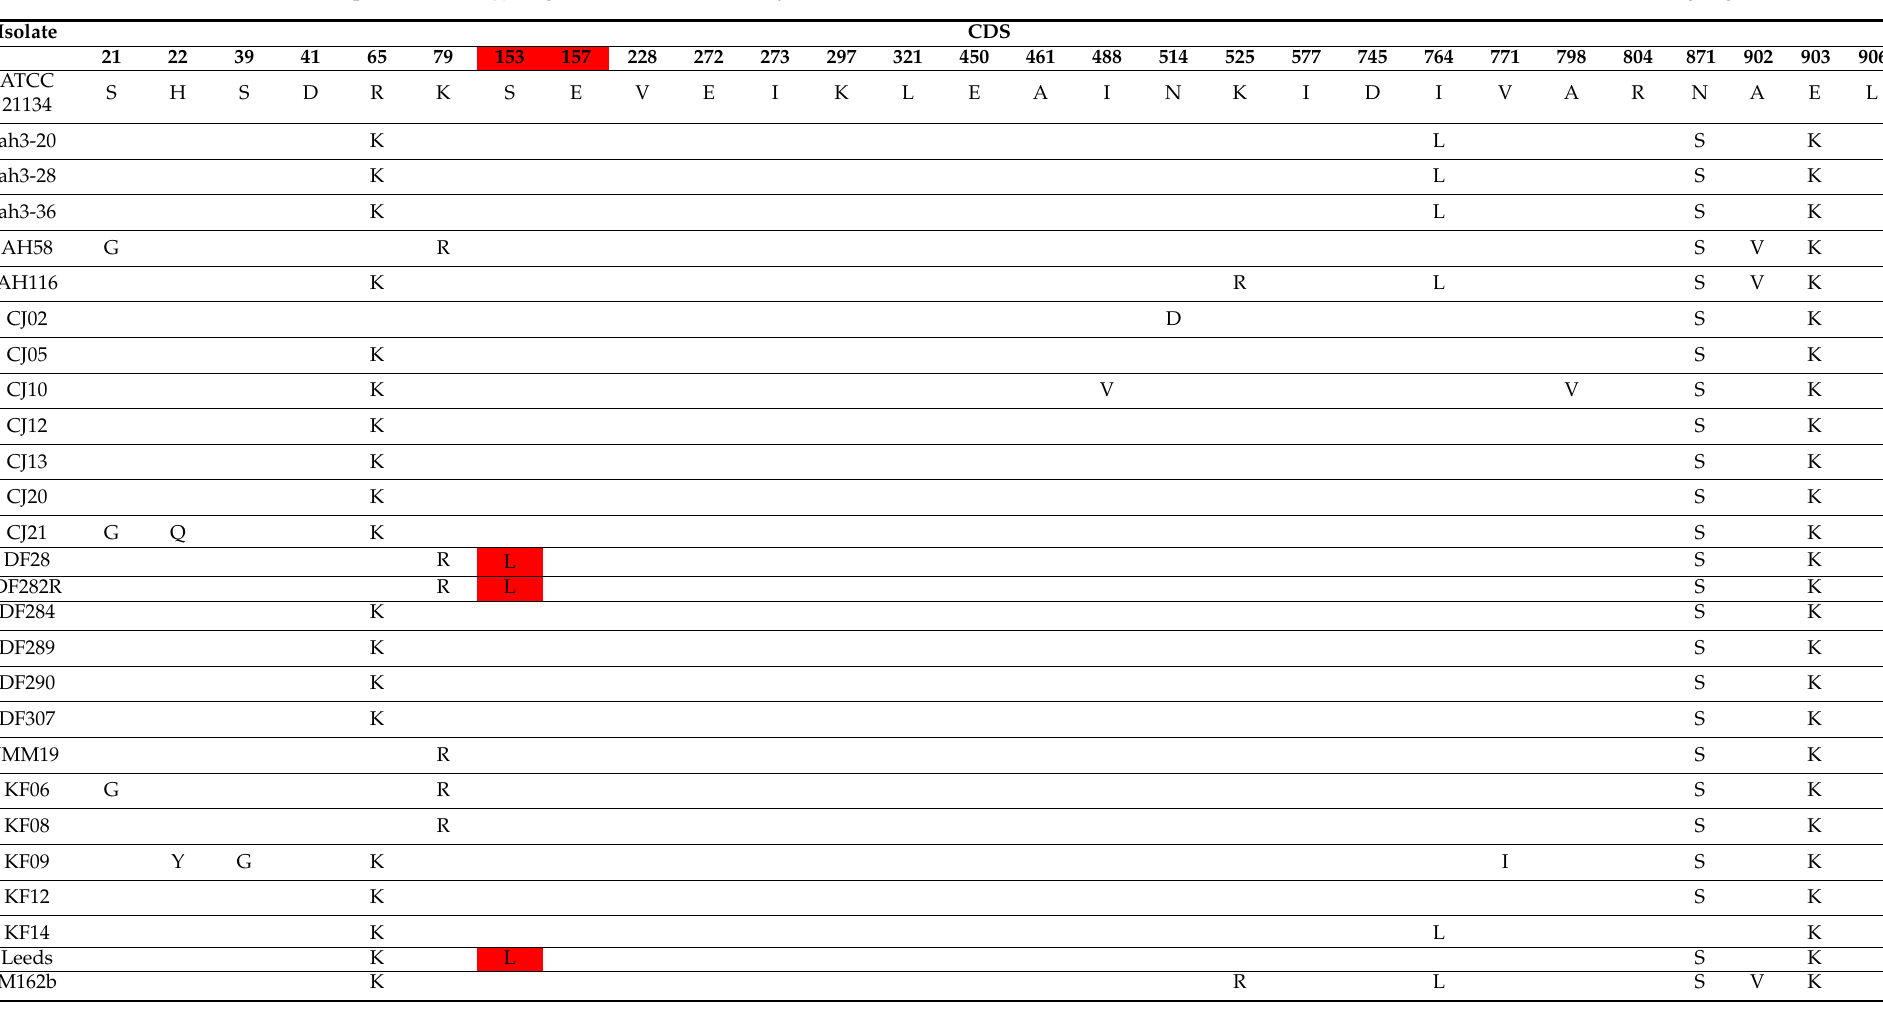
Table A1. Amino acid variations present in the gyrA genes of all isolates analyzed in reference to ATCC 21134. CDS numbers in the QRDR and associated mutations are highlighted in